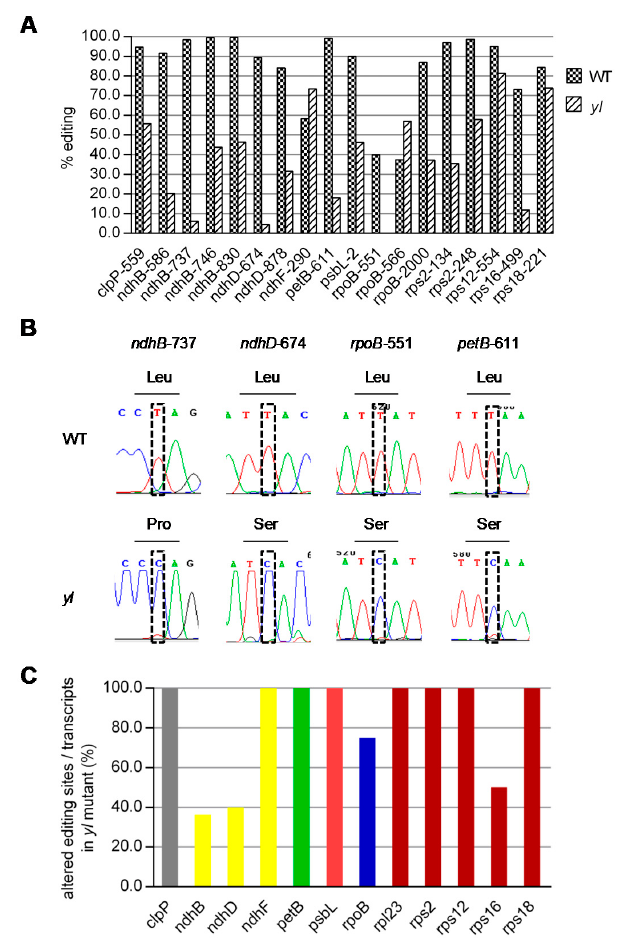
Figure 6. RNA editing at multiple chloroplast sites is impaired in the yl mutant. ( A ) Eighteen sites exhibit a significant alteration in editing of more than 10% in the yl mutant through RNA-seq analysis. ( B ) The three abolished editing sites and petB -611 in the yl mutant. Rectangular frames indicate defective editing sites. The corresponding amino acids are underlined. ( C ) Percentage of altered editing sites/transcripts in the yl mutant. Each bar shows a transcript color-coded in accordance with the complex to which it